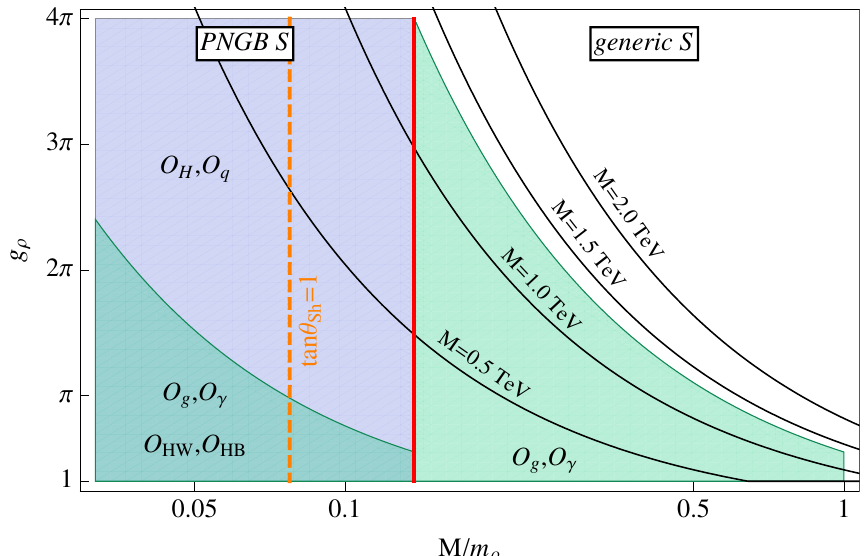
(cid:16) (cid:17) M Figure 3 . In the shaded regions of the ; g (cid:26) plane, the contributions to the operators of table 2 m (cid:26) induced by a PNGB (left from the red line) or a generic S (right from the red line) can become larger than those of the generic strong dynamics and thus alter the dynamics of the Higgs boson. 2 m 2 The red line corresponds to M 2 = 3 y , which we take as a lower bound on the generic S mass t (cid:26) (4 (cid:25) ) 2 and an upper bound on the PNGB S mass. The orange dashed line corresponds to tan (cid:18) Sh = 1 (for (cid:24) = 0 : 1) and, to the left from this line, the physical observables start being sensitive to interference of multiple S -induced operators. The black lines correspond to (cid:24) = 0 : 1, for M = 0 : 5 ; : : : ; 2 : 0 TeV ( (cid:24) increases towards the upper right corner). Since (cid:24) = 0 : 1 corresponds to the ultimate reach of the LHC with indirect searches for generic compositeness e(cid:11)ects only (in the absence of S ), the black line passing some colored region (i.e. with S e(cid:11)ects superseding compositeness e(cid:11)ects) means that corresponding indirect S e(cid:11)ects are detectable at the